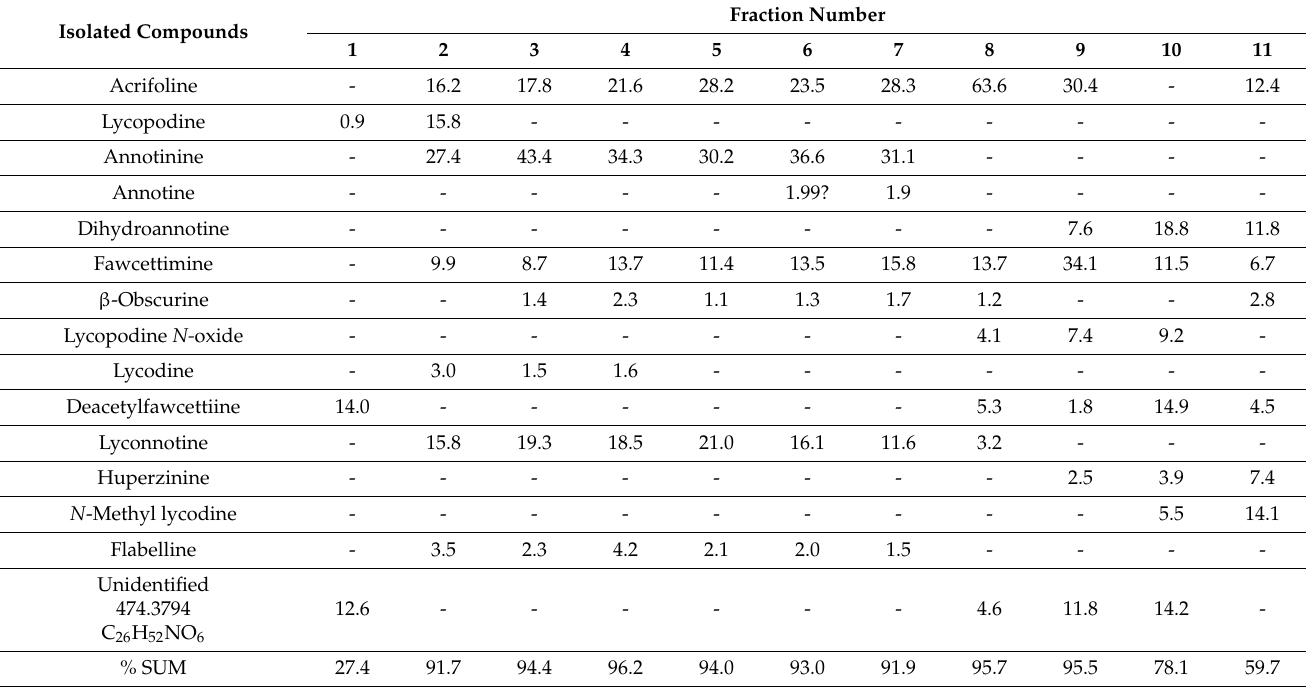
Table 4. Results of alkaloids identified via HPLC/ESI-QTOF-MS present in fractions 1–11 obtained from experiment 3 via VLC using silanized silica gel as a sorbent from L. annotinum extract. Isolated Compounds